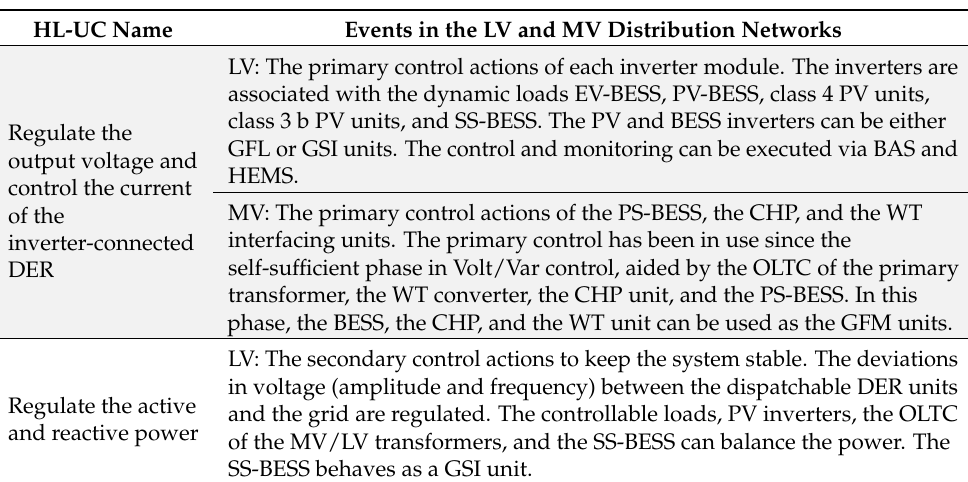
Table 6. Power balance management high-level use cases (HL-UCs) in the microgrid